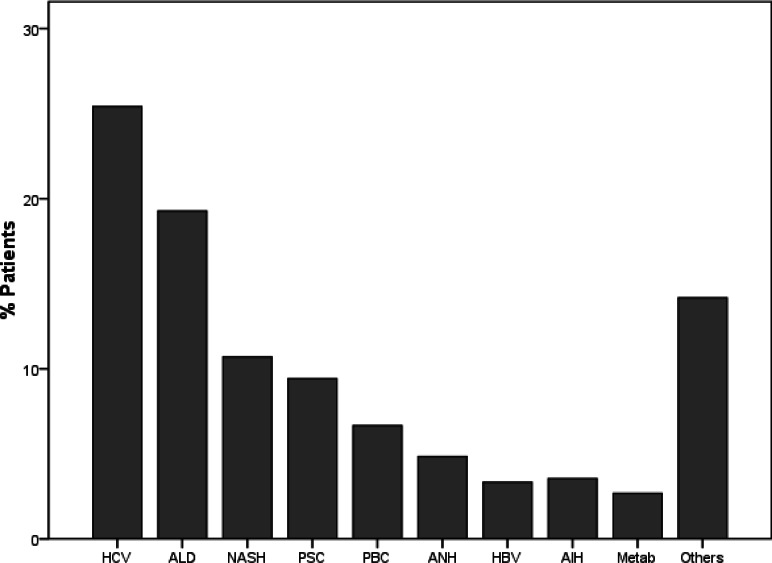
De novo malignancies in primary diagnosis.(PSC = primary sclerosing cholangitis, ALD = alcoholic liver disease, PBC = primary biliary cirrhosis, HCV = hepatitis C, NASH = cryptogenic cirrhosis, AIH = autoimmune hepatitis, AHN = acute hepatic necrosis, HBV = hepatitis B, Metab = metabolic disease.)